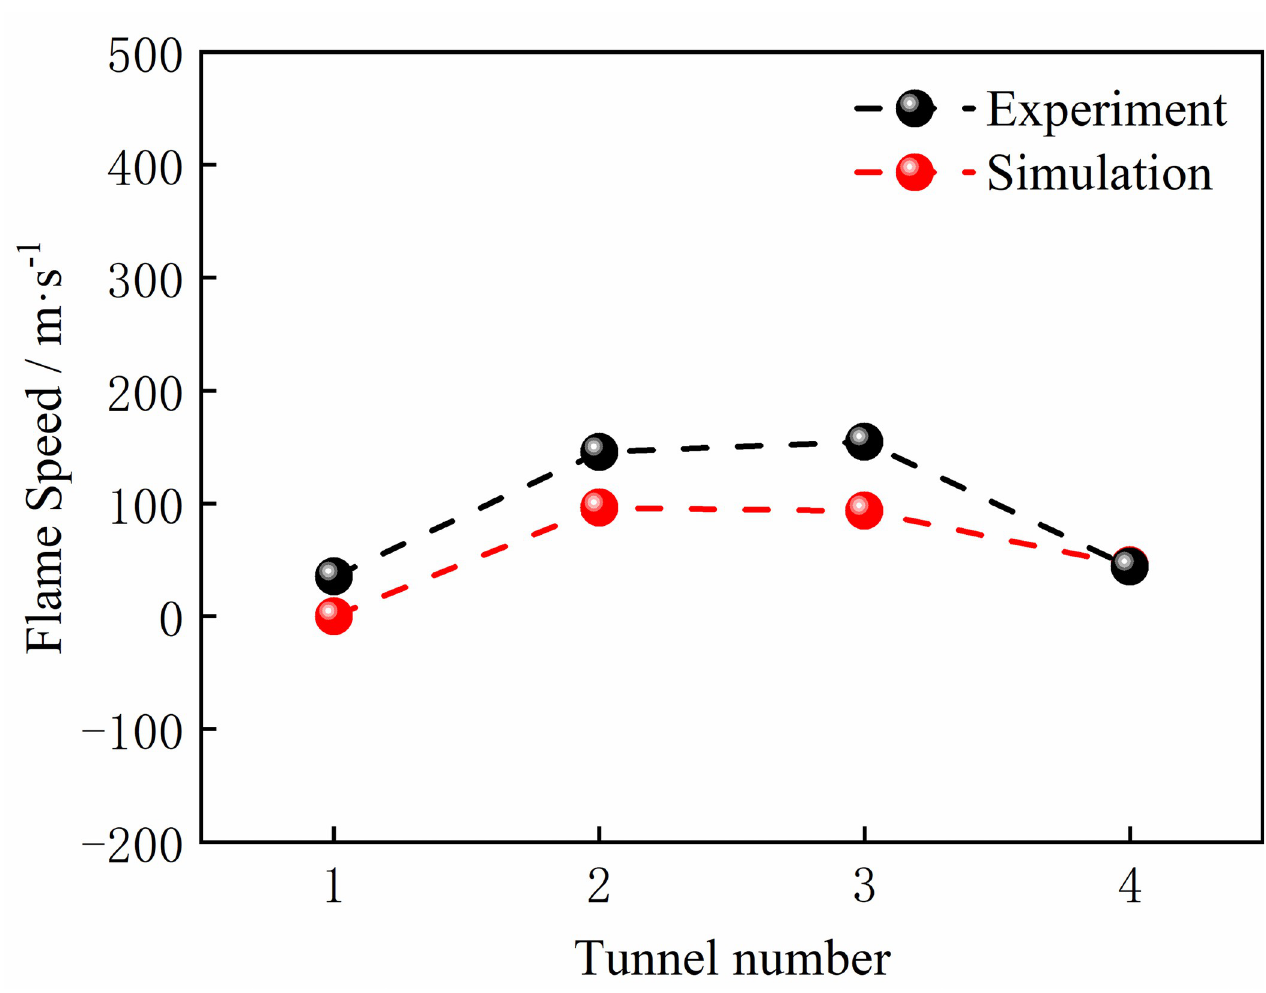
Fig 7. Experimental and simulant flame comparison at a concentration of